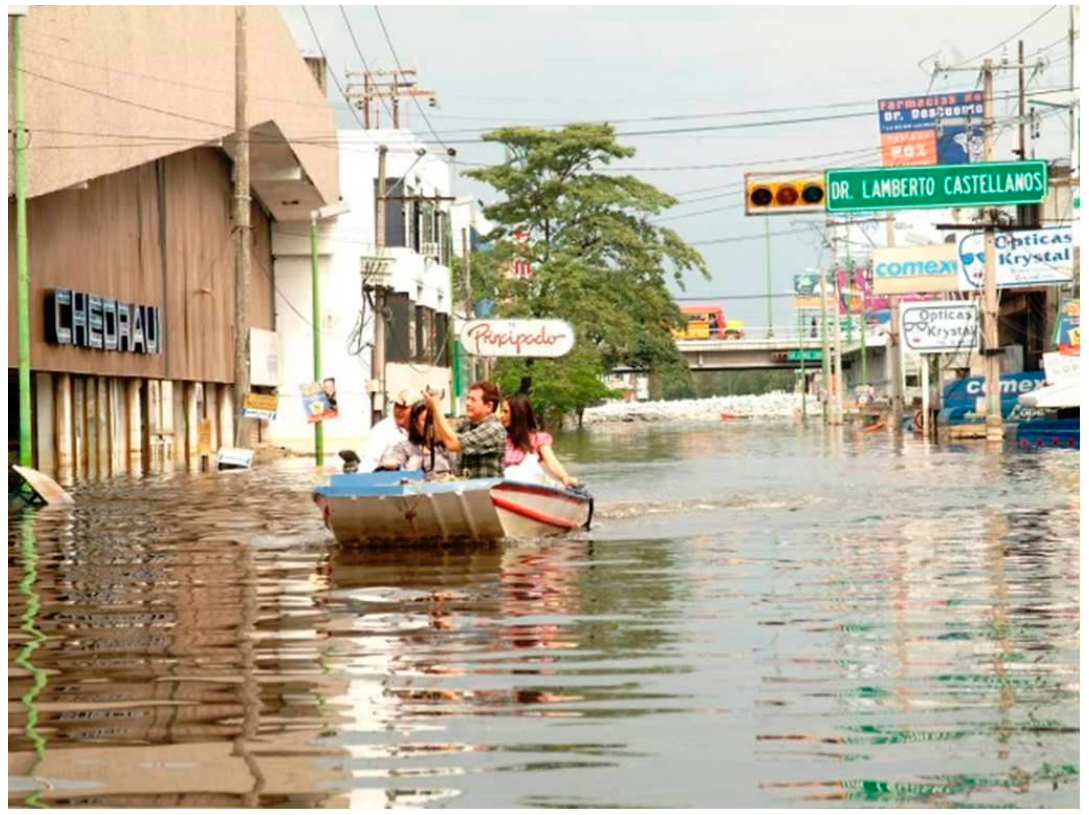
Figure 2. The city of Villahermosa flooded for 80% of its territory on October 28, 2007 (Tabascohoy). Between October 28 and 30, 2007, intense and extraordinary rains occurred in the Grijalva river catchment. Rains reached depths greater than 50 mm in some locations of the basin of the Peñitas dam, causing the need to open the dam floodgates. Other rivers of the drainage system that flows into Villahermosa also reached high levels, close to the critical thresholds defined for issuing alerts [9]. Generated floods covered an area equivalent to 70% of the Tabasco state territory affecting more than 1 million people. An example of rapid (flash) flooding was the event that occurred in October 2008 in the south of the Sonora state, as consequence of the hurricane Norbert. The amount of water precipitated in the mountain range caused runoff from the peaks of the mountains downstream to the coastal plains. The discharge energy of the runoff was so intense that materially destroyed vegetation, soil and rocks along the flow path. Heavy rainfall in 2010 generated by the passage of tropical depressions caused severe flooding in the states of Tabasco, Oaxaca, Veracruz, Zacatecas, and Chihuahua, affecting more than 10,000 people and many sectors of federal, state and municipal highways. Hurricane Jova, in 2011, affected the states of Colima and Jalisco (Figure 3), leaving communities isolated by the overflow of rivers; roads were closed and thousands of houses in coastal and mountainous communities remained without power and drinking water.